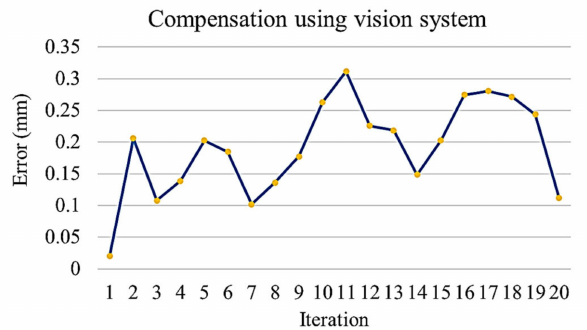
Figure 12. Positioning error after compensation using vision system in 20 repeat